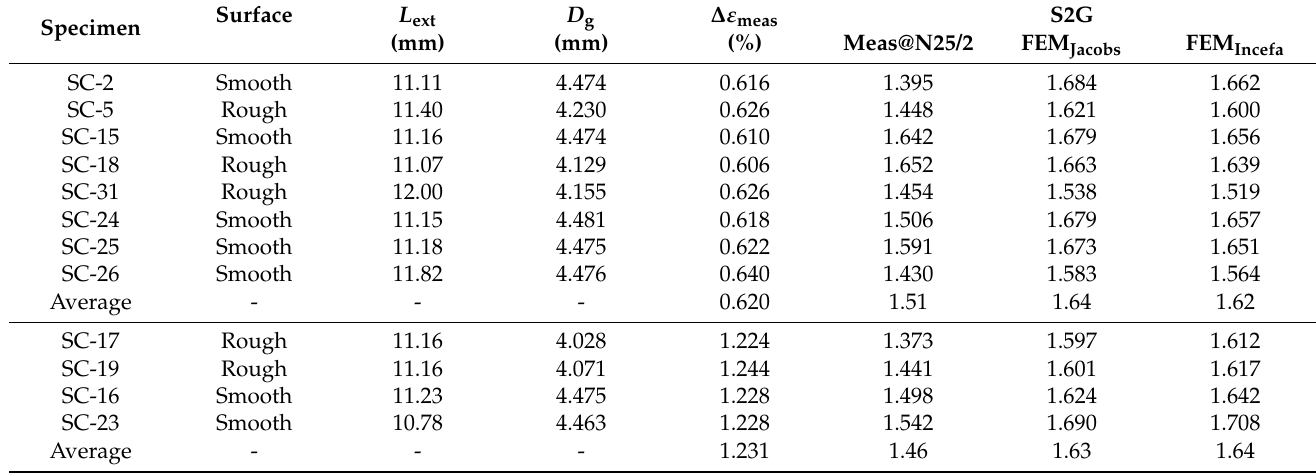
Table 7. S2G values for SCK-CEN specimen: extensometer position effect. Top part: Δ ε = 0.6%. Bottom part: Δ ε = 1.2%.